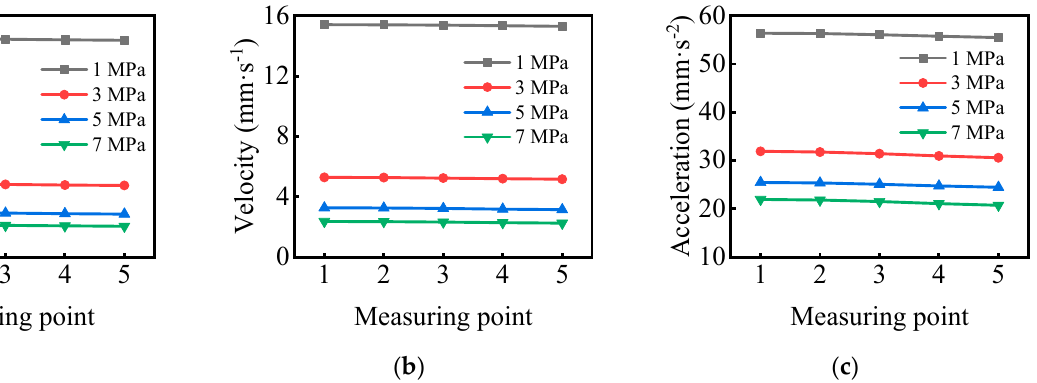
Table 6. Results of peak displacement, velocity, and acceleration at the mid − span measuring point when the elastic modulus of soil layer changes.